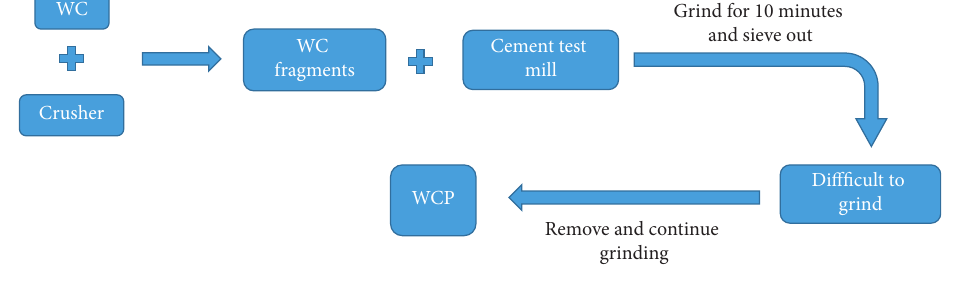
Figure 1: Production process of WCP.